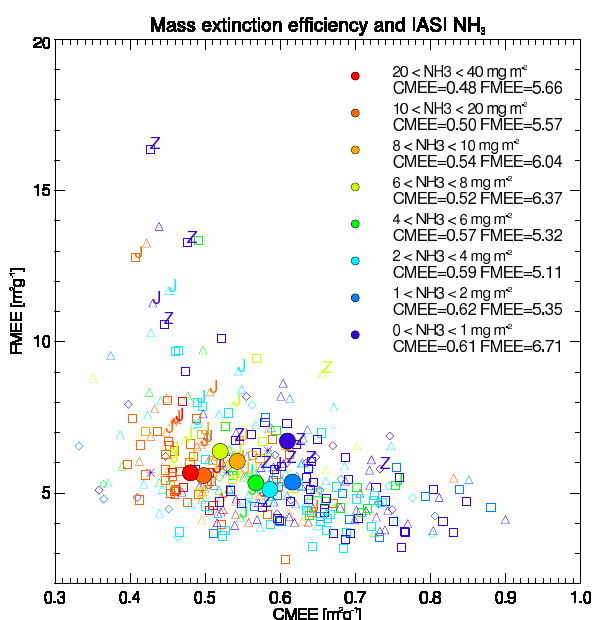
Fig. 5. Daily mass extinction efficiency (m 2 g − 1 ) for coarse (CMEE) and fine (FMEE) modes at all AERONET stations from April 2009 to March 2010 when the Angstrom exponent is less than 0.5, and as a function of IASI NH 3 column burden for 8 ranges of values (colors), with mean values of FMEE and CMEE given in units ofm 2 g − 1 provided in upper right. The correspond- ing season is indicated by star (December-January-February), trian- gle (March-April-May), square (June-July-August), and diamond (September-October-November) symbols. The Zinder Airport and Jaipur AERONET sites are indicated by the letter Z and J, respec- tively.